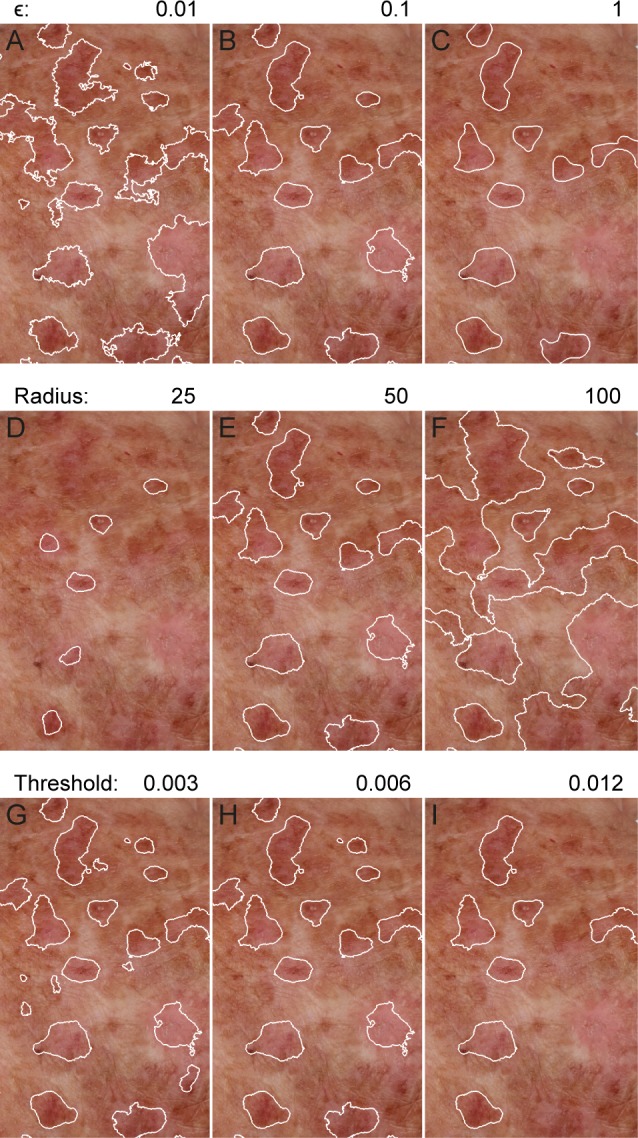
Impact of different parameters on automatically identified actinic keratosis lesions.A-C) The texture regularization parameter ϵ controls how smooth the detected lesions boundaries are. D-F) The radius of the disc used in morphological opening by reconstruction controls the size of detected lesions. G-I) The high hysteresis threshold controls whether or not a potential lesion is included based on the maximum erythema intensity.